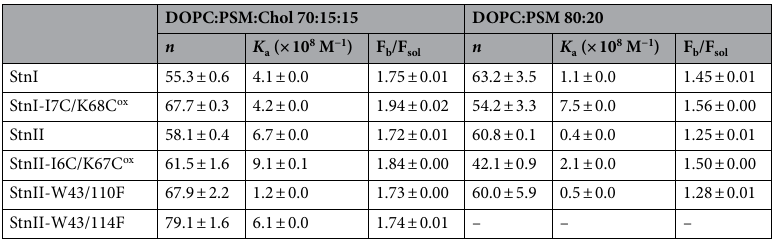
Table 1. Affinity ( K a ), stoichiometry ( n ) of the interaction, and increase in emission (F b /F sol ) of WT sticholysins and several of its mutants upon interaction with membranes of different compositions. Values of n and K a are obtained from fitting using non-linear least squares. Note that the stoichiometry, n , is understood as a protein monomer binding the membrane every n lipids, not necessarily interacting directly with all of them. Values are average ± SEM (n =